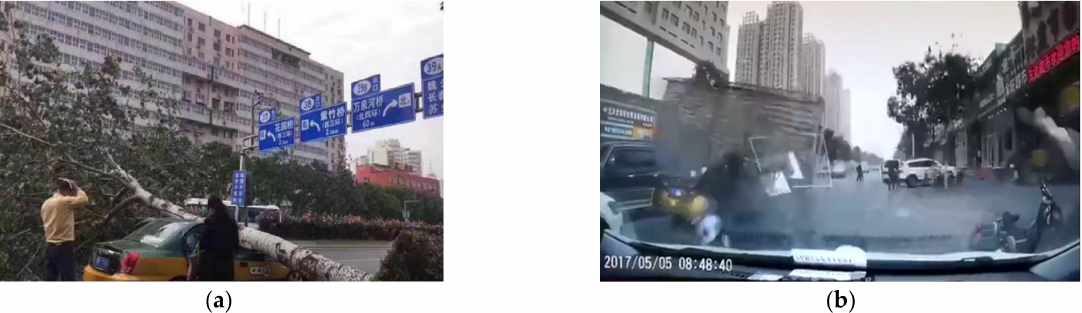
Figure 1. On 5 May 2017, a tree was blown down by intense wind and hit a car ( a ) https://news.qq.com/a/20170505/025 960.htm (accessed on 5 May 2017); a billboard was blown down and injured a pedestrian ( b ) (https://v.qq.com/x/page/n0 500nddjni.html? (accessed on 5 May